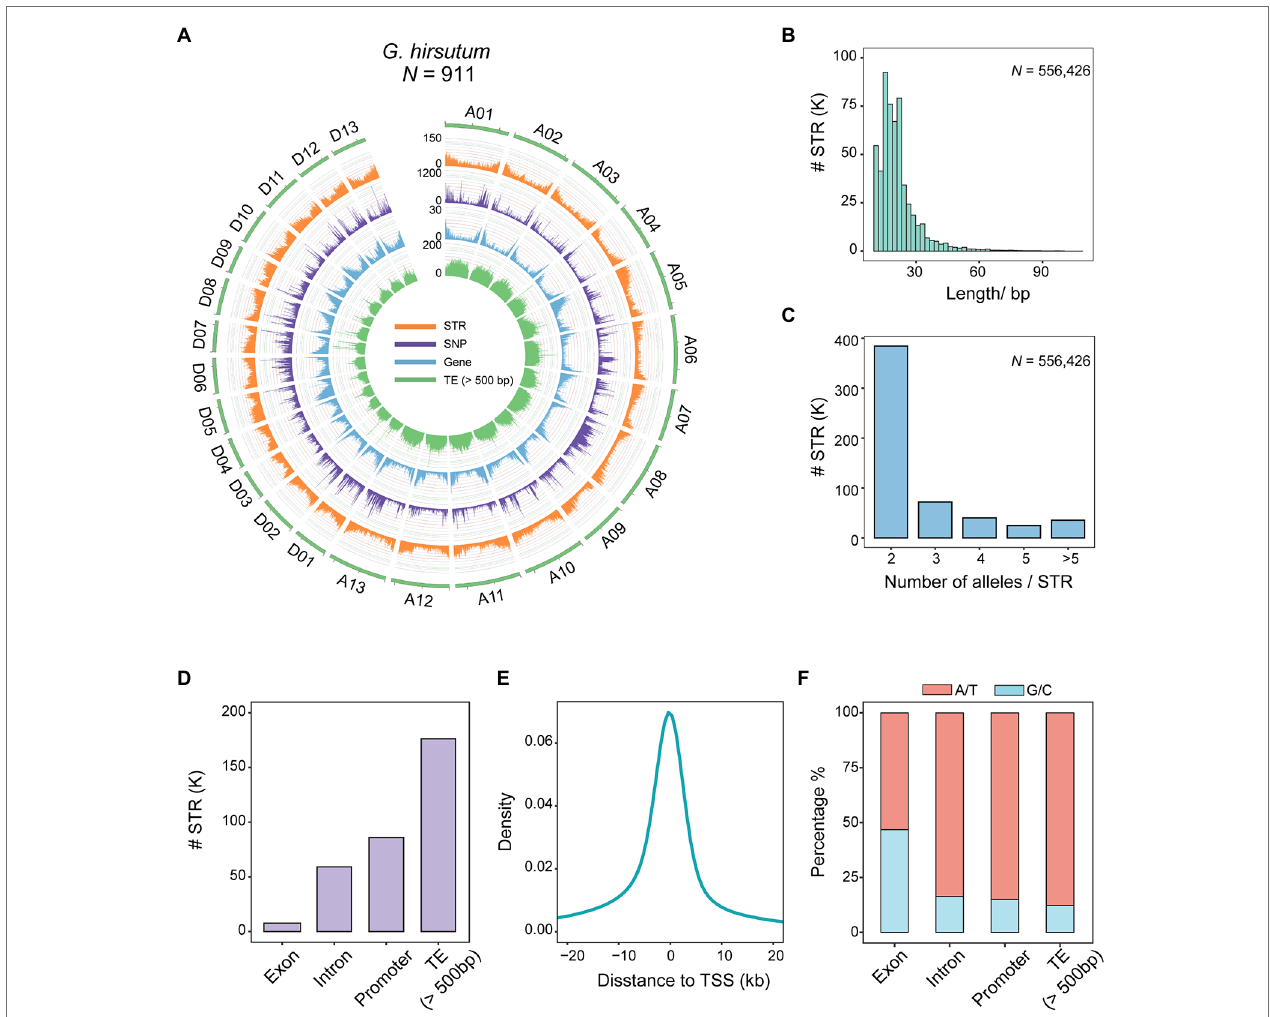
FIGURE 1 | Polymorphic STR map of 911 cotton accessions. (A) Genomic distribution of polymorphic STRs in 911 allotetraploid cotton accessions. The 26 allotetraploid chromosomes, A01-D13, are represented in green. From outer ring to inner, curves represent the distributions of STRs, SNPs, genes, and TEs (>500 bp). (B) Distribution of STR motif lengths (length of the reference sequence at each locus). (C) Bar plot showing STR allele numbers. (D) Bar plot showing STR distributions within different genomic features [exons, introns, promoters, and TEs (>500 bp)]. (E) Density of STRs in relation to gene transcription start sites (TSSs). (F) CG composition of STR motifs according to associated genomic